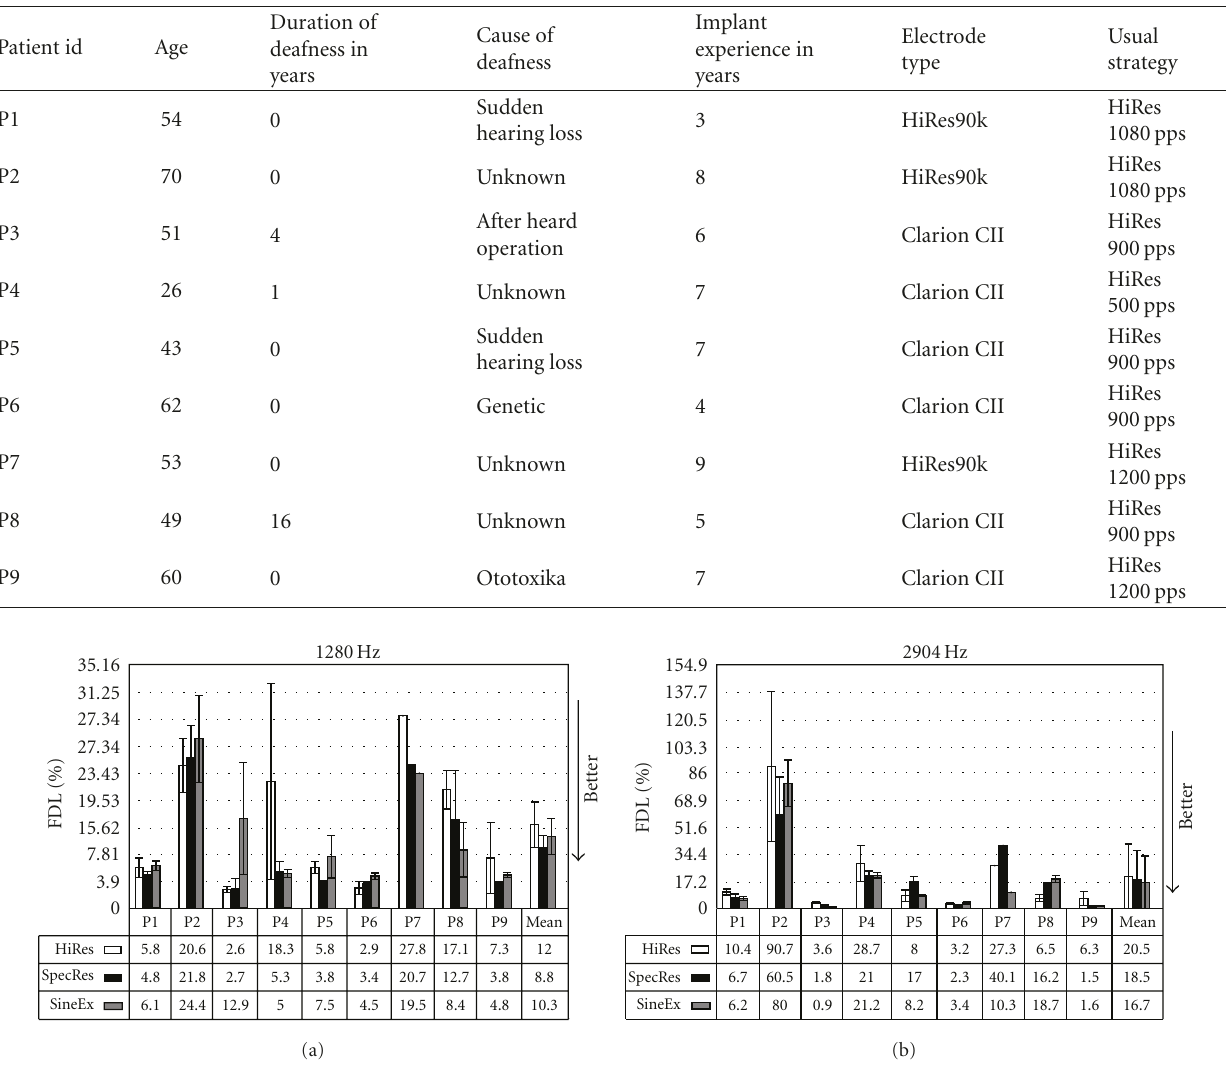
Figure 9: Frequency discrimination limen by subject (average and standard deviation) for the frequency discrimination test at di ff erent reference frequencies (a) 1280 Hz and (b) 2904 Hz with HiRes, SpecRes, and SineEx. The frequency discrimination limen is presented as percentage of the reference